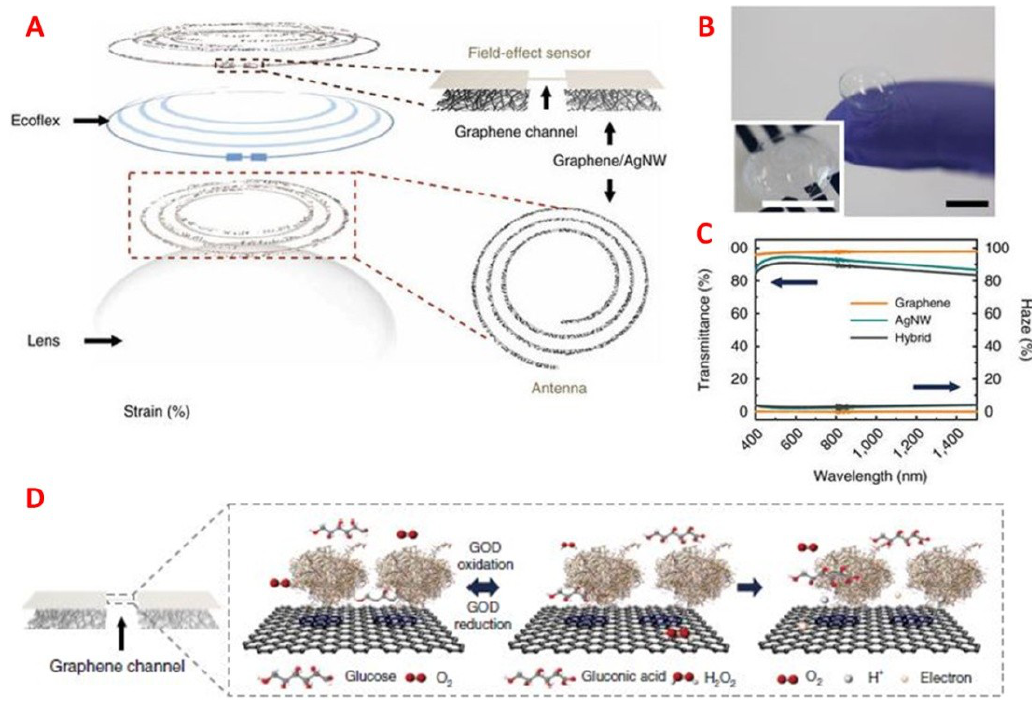
Figure 10. ( A ) Schematic of the wearable contact lens biosensor, integrating glucose, and intraocular pressure sensing. ( B ) Image of the fabricated contact lens sensor. The scale bar is 1 cm. ( C ) Optical transmittance and haze of graphene, silver nanowire film, and a hybrid structure. ( D ) Glucose detection with GOD‐pyrene functionalized graphene. Reproduced and adapted with permission [102]. Copyright 2017, Springer Nature.